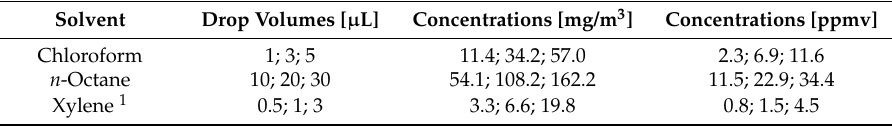
Table 3. Applied volumes and concentrations in mg/m 3 and ppmv (parts per million volume) of the organic solvents used for the VOC sensing